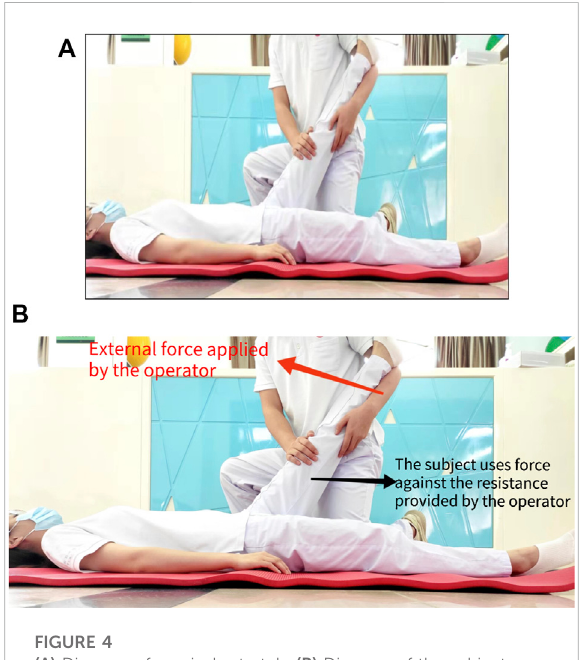
FIGURE 4 (A) Diagram of passively stretch. (B) Diagram of the subject contract the hamstring